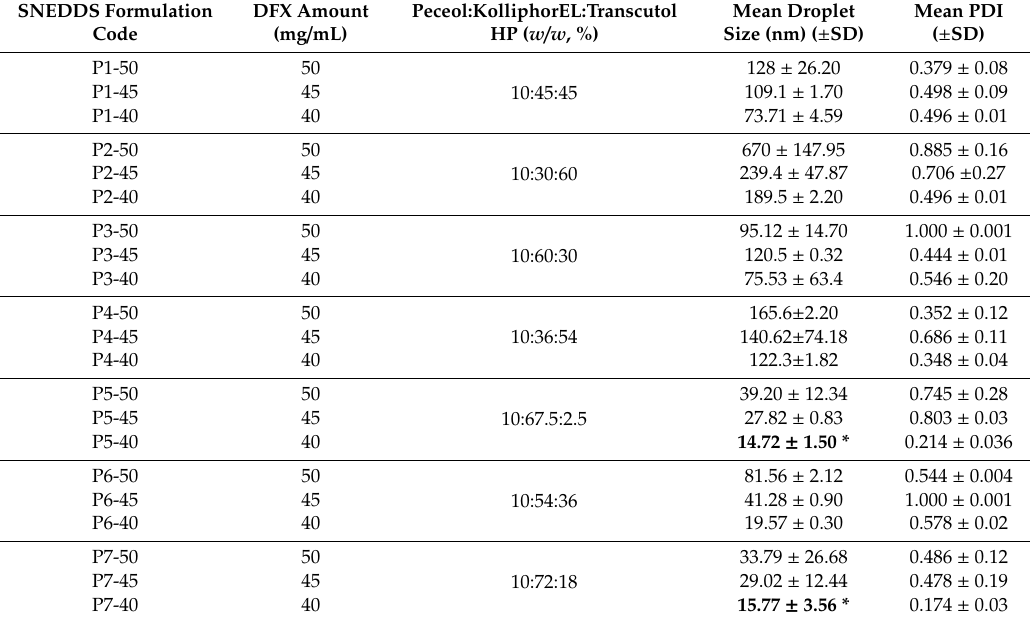
Table 2. E ff ect of amount of DFX loaded into the SNEDDS formulations on the droplet size and PDI of SNNEDS ( n =